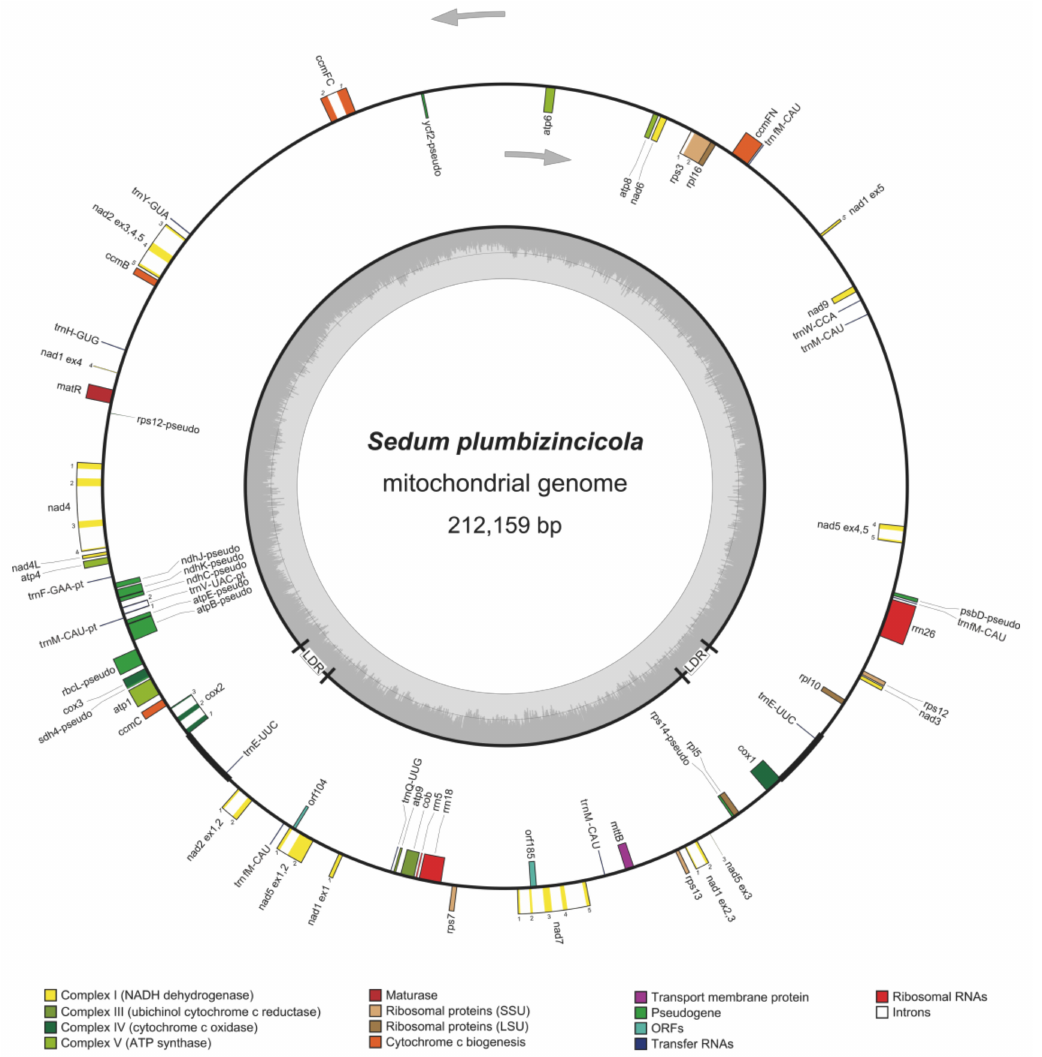
Figure 1. Mitogenome annotation map for S. plumbizincicola . Genes lying outside the circle are transcribed in a clockwise direction, whereas genes inside are transcribed in a counterclockwise direction. The dashed darker and lighter gray in the inner circle denote G + C and A + T contents of mitochondrial genome, respectively. LDRs mean large direct